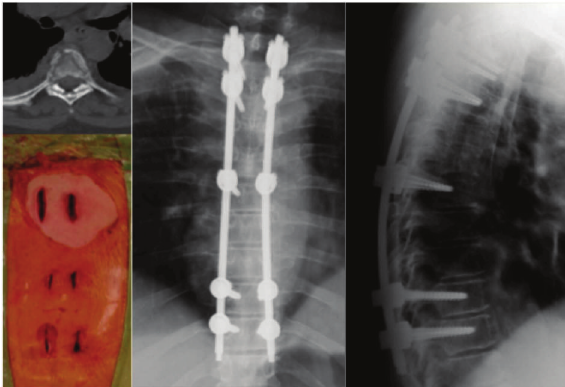
Figure1:A59-year-oldfemalewithfracturesofT4andT5,multiple, bilateral rib fractures, fractures of the spinous processes of T4/5/6/7, and lung contusion, treated surgically by posterior fixation with long instrumentation carried out percutaneously with screws implanted in